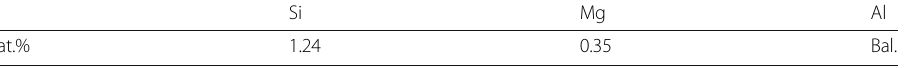
Table 1 Chemical composition of the alloy used for the mixed-mode growth modelling Si Mg Al at.% 1.24 0.35